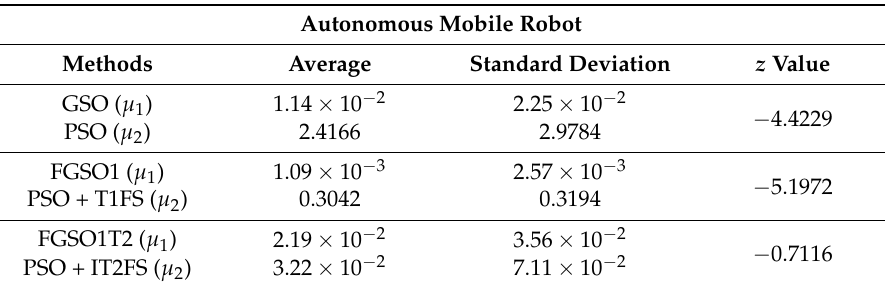
Table 7. Results for the z test between the proposal and PSO [4] without noise.